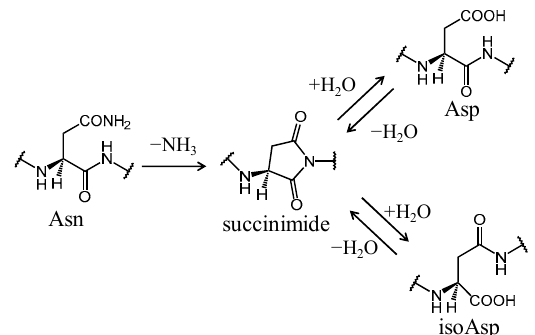
Figure 1. Succinimide-mediated deamidation pathways of asparagine (Asn) residues.